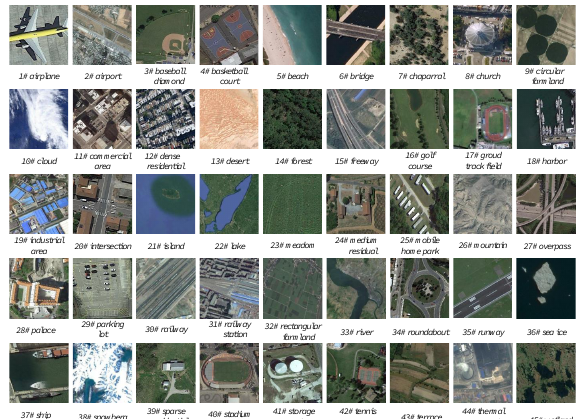
Figure 4. some examples from the NWPU-RESISC45 data